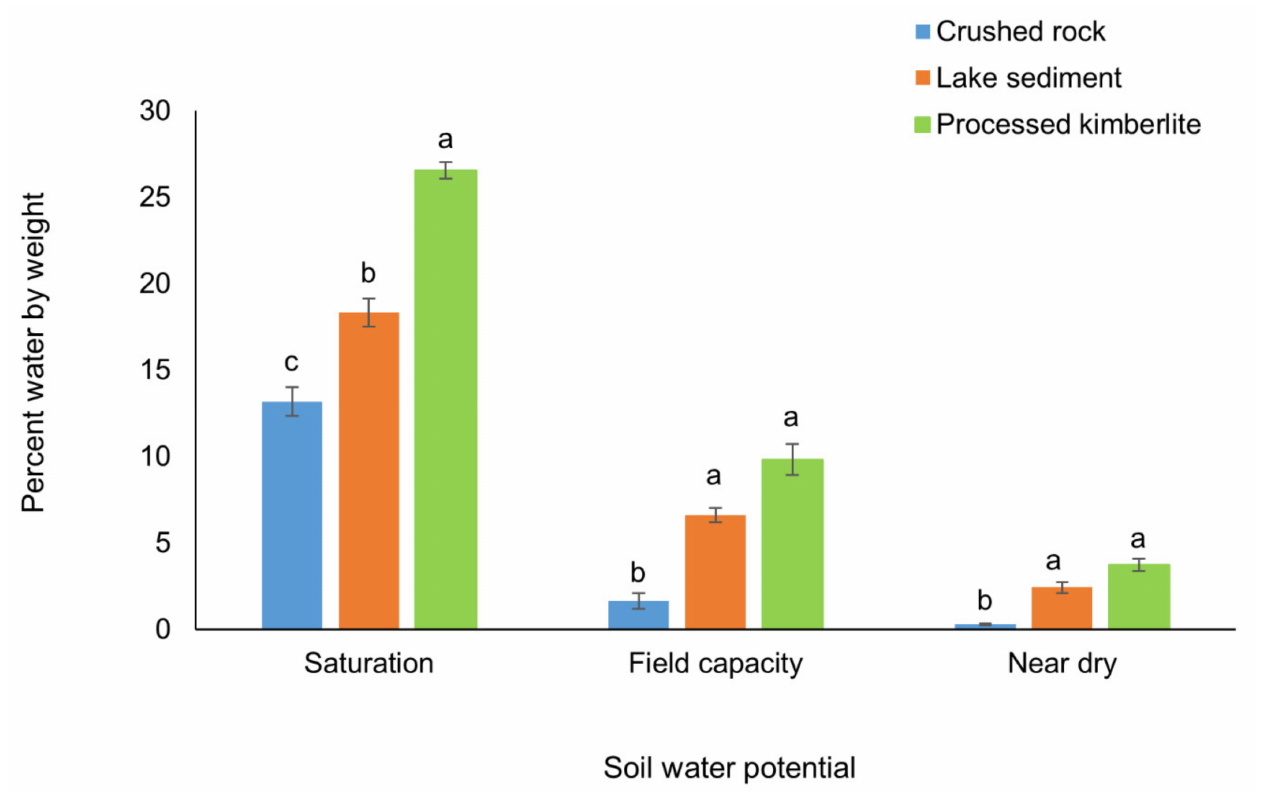
Figure 3. Mean percent water by weight at saturation, field capacity, and near dry for different substrates. Different letters indicate significant differences at p = 0.05 in Tukey HSD post hoc